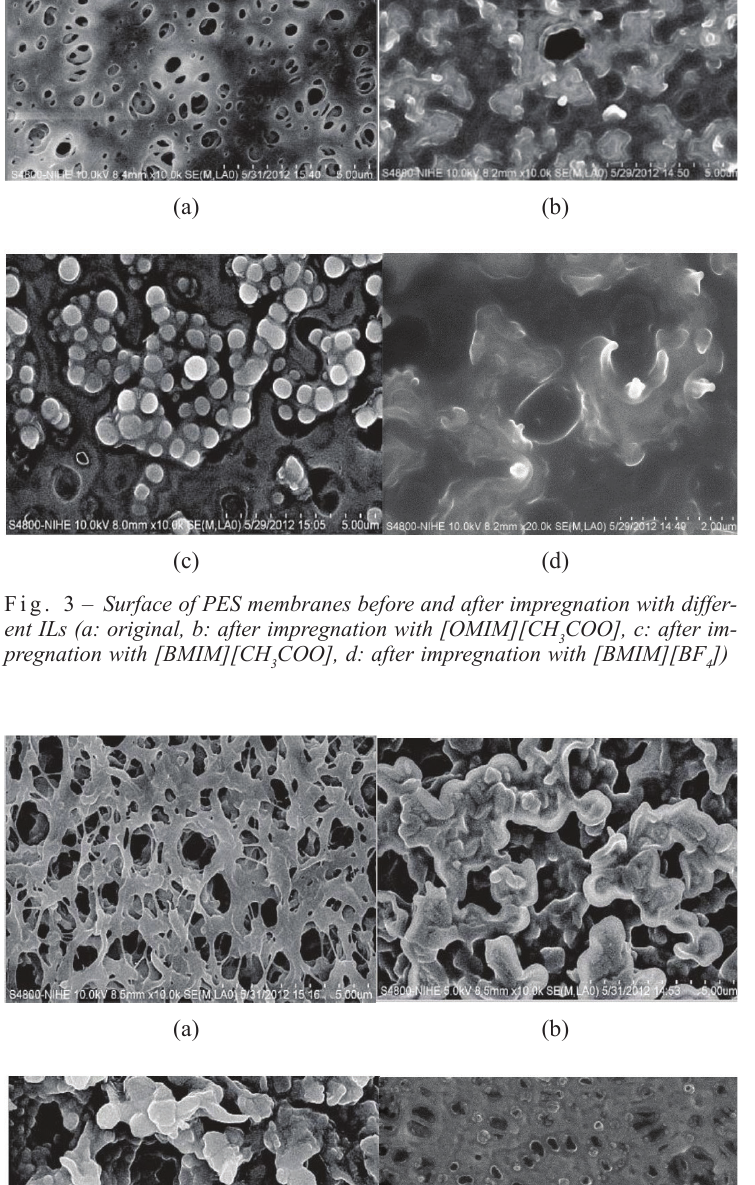
COO], c: after 3 4